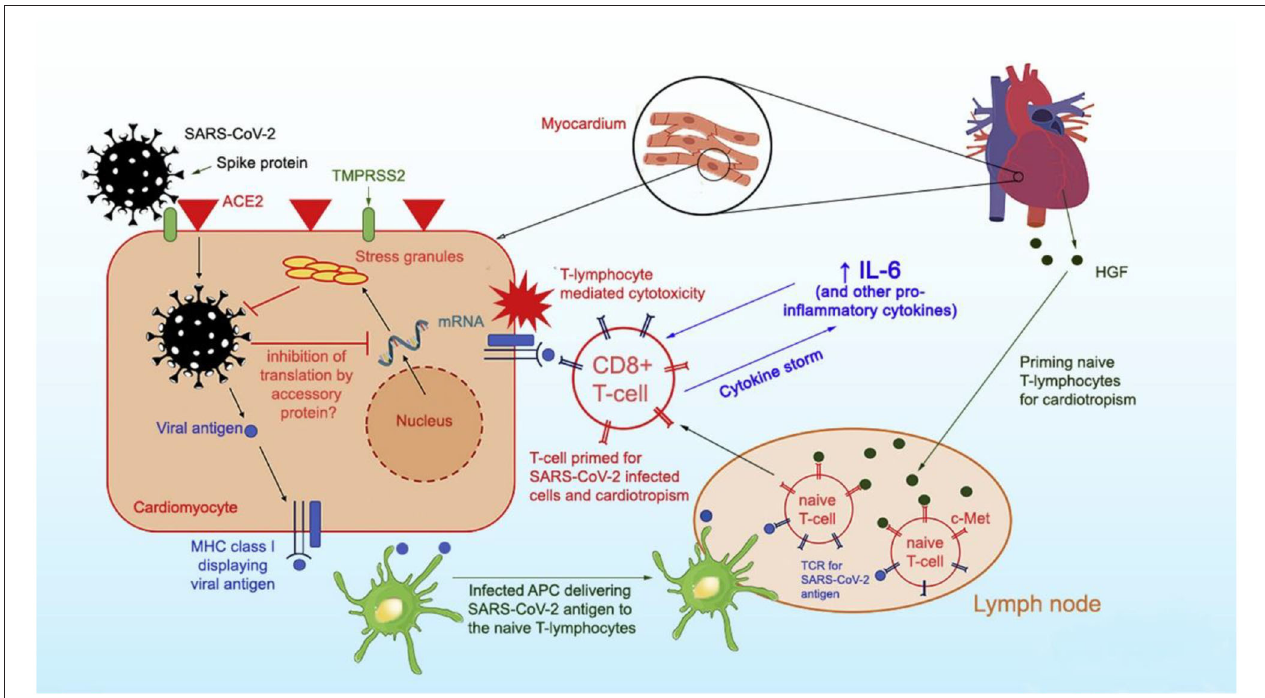
FIGURE 1 | Proposed mechanism of SARS-CoV-2 entry into myocytes and inflammatory pathways causing viral myocarditis. Reprinted with permission